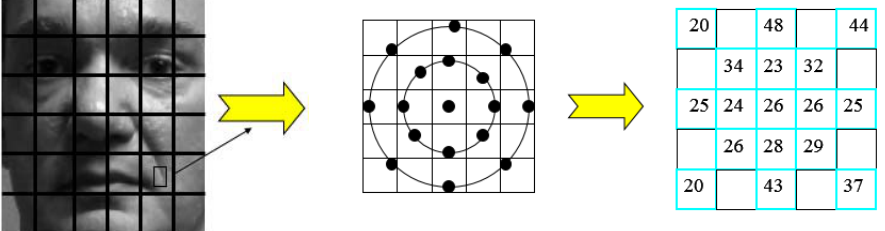
Figure 3. The Double Radii LBP model. N = 8, R1 = 2.5, R2 = 1.5. The left is the model and we mark the pixel value of the sampling points in the